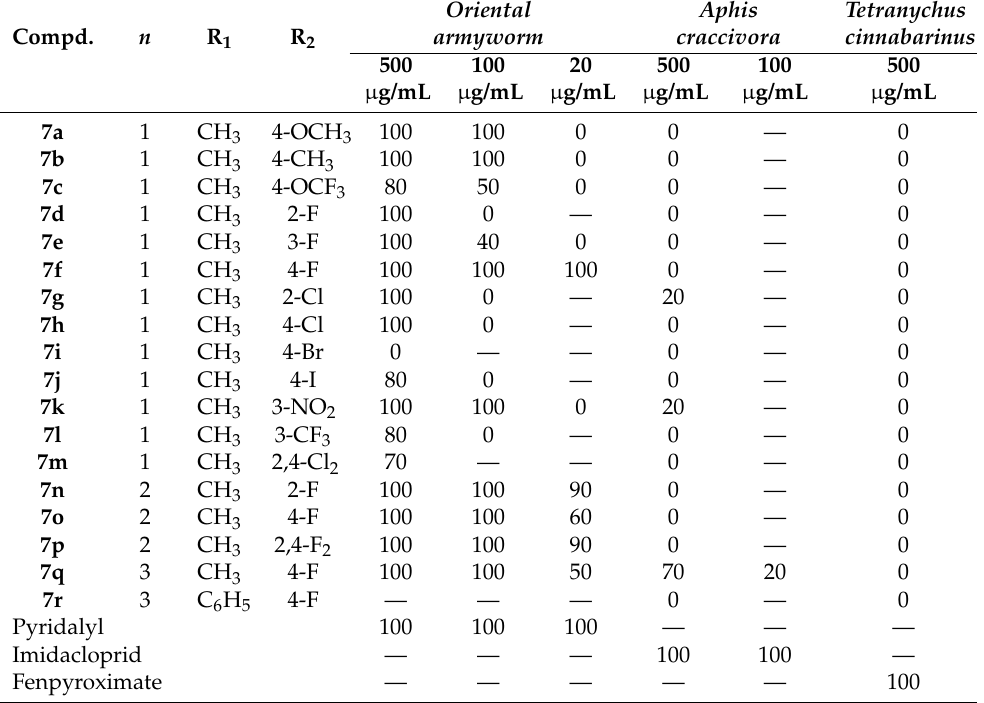
Table 1. Insecticidal and acaricidal activities of compounds 7a – 7r (mortality, %).